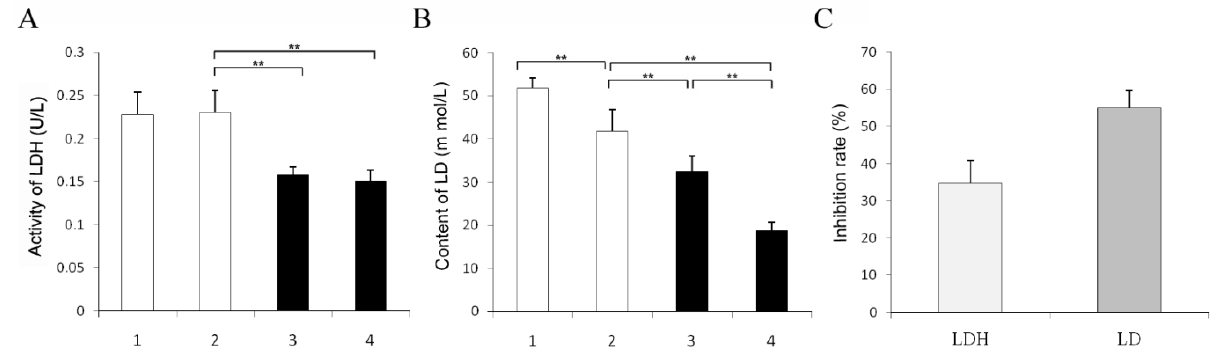
Figure 6. Effects of N -isopropyl oxamate on the activity of LDH, content of LD and ATP in the serum of plateau pika. ( A ) LDH activity in the serum of plateau pika with different treatments. ( B ) LD content in the serum of plateau pika with different treatments. ( C ) Inhibition rates of LDH and LD in the serum. Group 1: taking samples when swimming till exhausted with each bilateral biceps femoris of hind legs injected 0.5 mL normal saline; Group 2: taking samples with each bilateral biceps femoris of hind legs injected 0.5 mL normal saline; Group 3: taking samples when swimming till exhausted with each bilateral biceps femoris of hind legs injected 0.5 mL 1mol/L isopropyl oxamate; Group 4: taking samples with each bilateral biceps femoris of hind legs injected 0.5 mL 1 mol/L isopropyl oxamate. All animals were forced to rest for 30 min after injection. Water temperature: 9–10 °C. All data were expressed as mean ± SD; sample size was 10 for each group. The activity of LDH in Group 1–4 were 0.23 ± 0.026 U/mg, 0.23 ± 0.025 U/mg and 0.16 ± 0.009 U/mg and 0.15 ± 0.014 U/mg, respectively; the LD content in Group 1–4 were 51.86 ± 2.23 mmol/g, 41.71 ± 5.04 mmol/g and 32.29 ± 3.76 mmol/g and 18.80 ± 1.97 mmol/g, respectively; the inhibition rates of LDH and LD in the serum were 34.87% and 54.93 %, respectively. ** p <